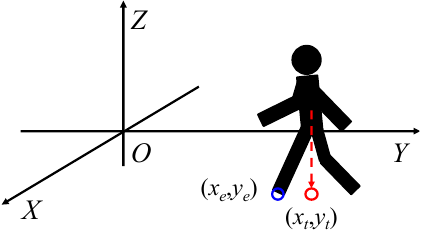
Figure 16. Example of the dynamic hazardous object detection. Sensors 2017 , 17 , 2936 Figure 17. Reason of the average error in the dynamic hazardous object.